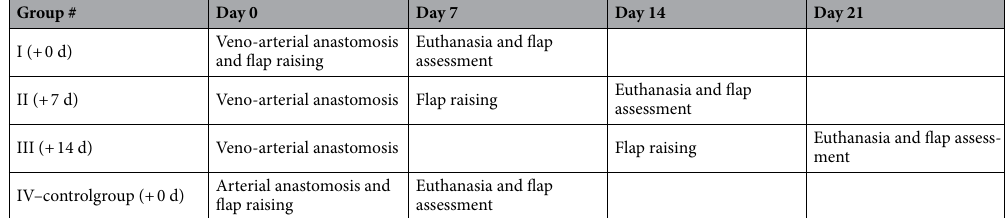
Table 1. Experimental protocol for the different groups ( n = 11 rats each group). Groups I–III included rats with a veno-arterial anastomosis. Group I included rats with a veno-arterial anastomosis without preconditioning: the epigastric flap was raised, and a purely venous perfusion system was constructed. On the same day, the flap was sutured back into the epigastric defect (Fig. 1). In group II, a veno-arterial anastomosis was constructed, but the flap was raised and set back into the epigastric defect 7 days later for preconditioning. In group III, a similar venous-only perfusion was constructed, but the flap was raised and set back after an interval of 14 days for a longer preconditioning period. In the control group (IV), a standard arterial epigastric flap (based on the epigastric pedicle) was raised, the epigastric artery with its femoral origin was cut and re-anastomosed, and the flap was directly sutured back into the epigastric defect. All flaps were assessed 7 days after flap